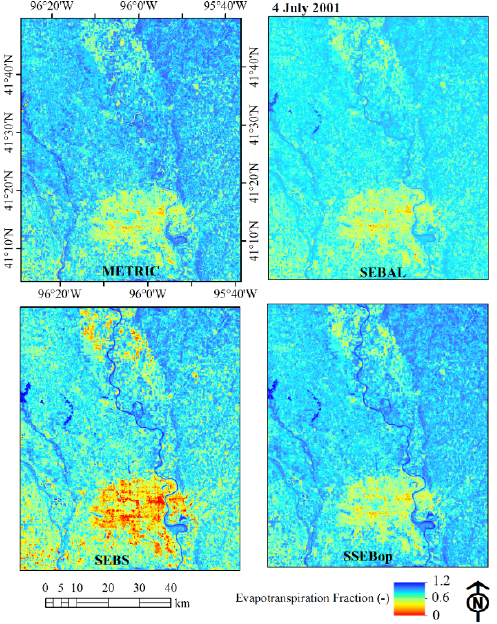
Figure 6. Evaporative fraction map computed using the METRIC, SEBAL, SEBS, and SSEBop models from the Landsat image acquired on 4 July 2001.